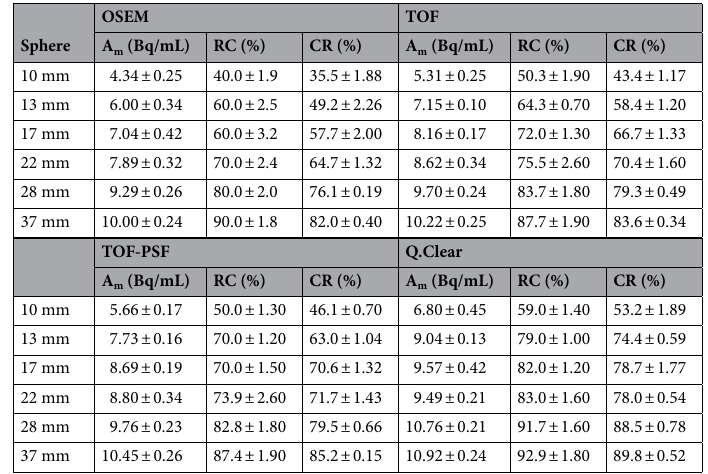
Table 1. The average uptake Am, recovery coefficient, and contrast recovery determined from 6 hot spheres.